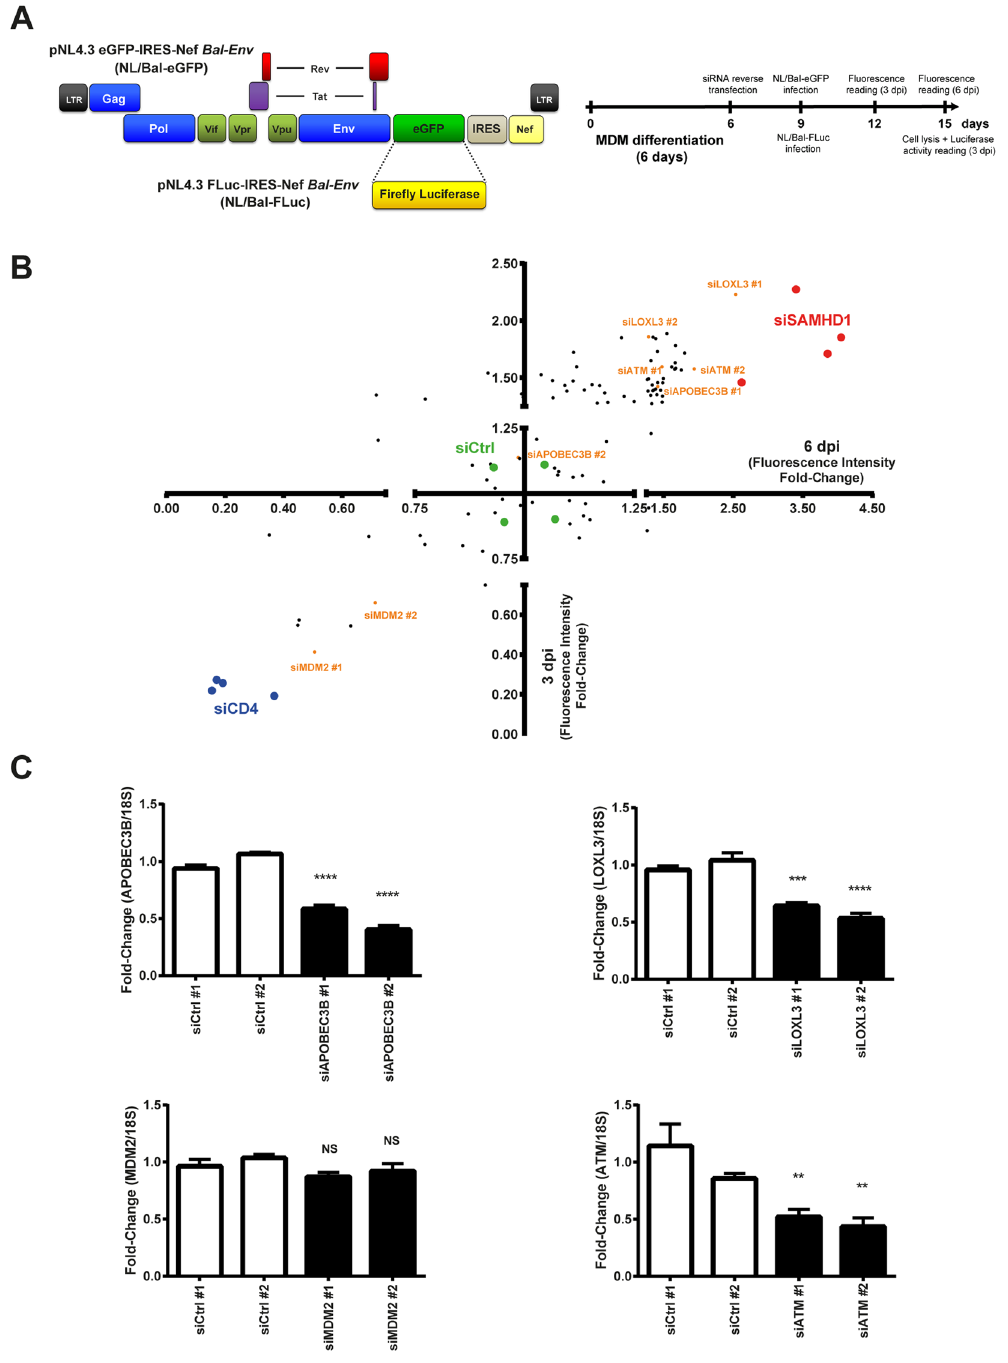
Figure 6. siRNA screen reveals new regulators of HIV-1 replication in MØ. ( A ) Vector maps of fully competent infectious molecular clones NL/Bal-eGFP and NL/Bal-FLuc (left panel) and schematic representation of the experimental protocol used in the siRNA screen (right panel). ( B ) siRNA sequences directed against fifty different host genes selected from RNAseq analyses allowed identification of interesting candidates for new regulators of HIV-1 replication in MØ ( orange dots ). siRNAs directed against SAMHD1 were used as controls for restriction factors ( red dots ) and siRNAs against CD4 were used as controls for susceptibility factors ( blue dots ). Data are presented as the mean of six independent experiments. ( C ) Transcriptional expression of MDM2 , LOXL3 , ATM and APOBEC3B genes was monitored following siRNA delivery. Data are presented as the mean ± SD. Asterisks denote statistically significant data ( ** p < 0.01; *** p < 0.001; **** p < 0.0001; NS: not